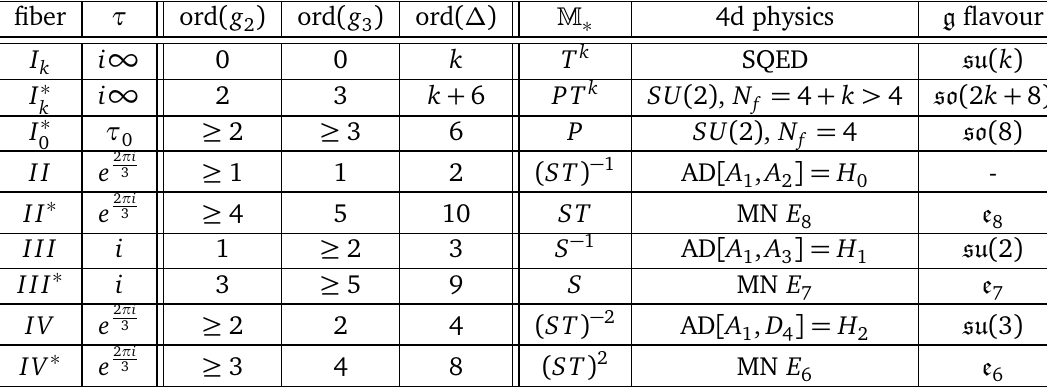
Table 4: Kodaira classification of singular fibers and associated 4d low-energy physics. The I fibers are also called ‘multiplicative’ or ‘semi-stable’ fibers. ( I k the ‘stable’ generic smooth fiber.) All the other types of fibers are called ‘additive’ or